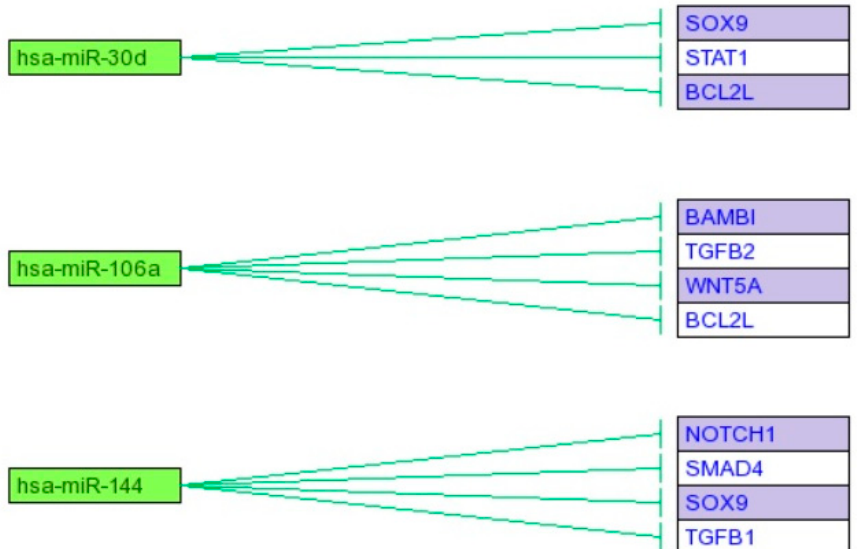
Figure 3. Predictive analysis of expression regulation of selected genes connected with EMT through miR-144, mir-106a, and miR-30d.